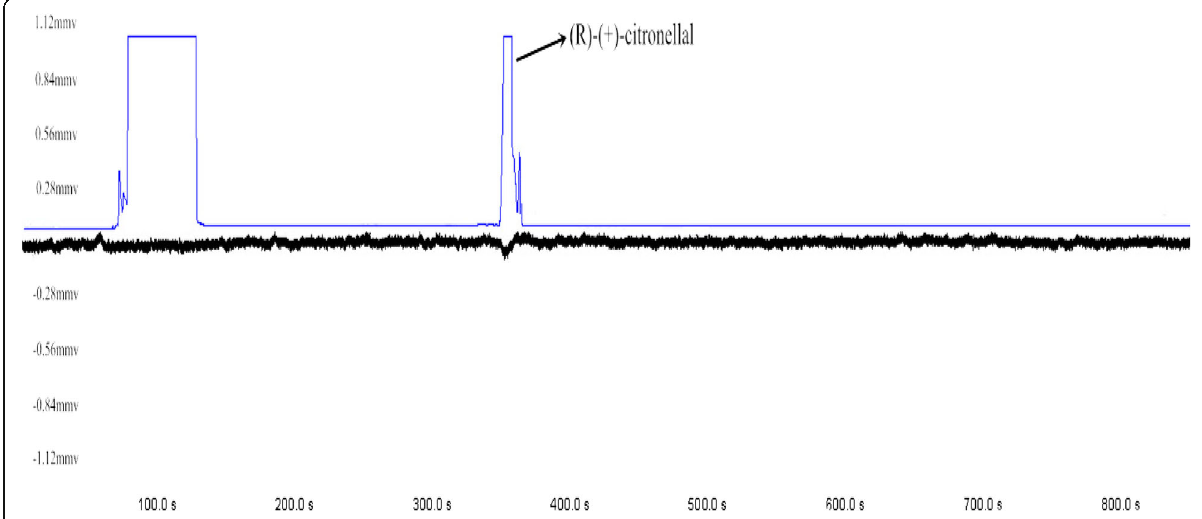
Fig. 3 Coupled gas chromatography-electroantennogram analysis of ( R )-(+)-citronellal (7.5 μ g). The upper trace is the chromatogram; the lower inverted trace is the electroantennogram signal from the antenna of A. bungii